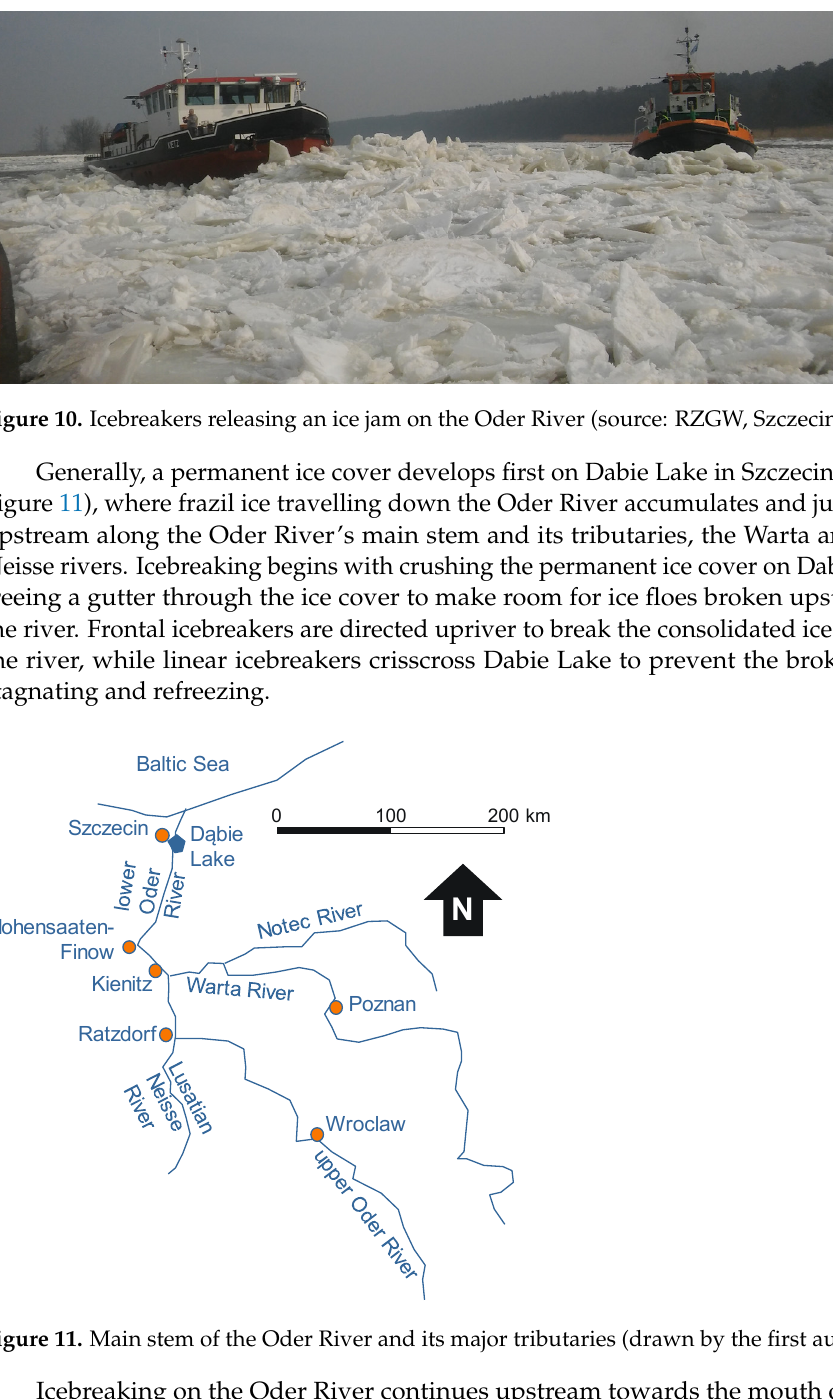
Figure 9. Correlation between average air temperature in the cool half-year (November to April)